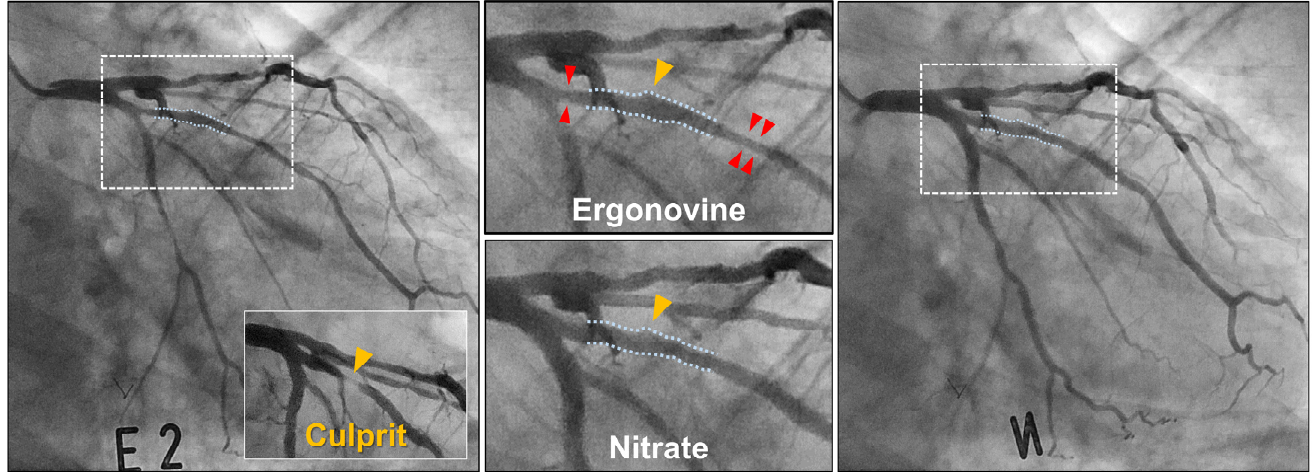
Figure 4. DCB-treated lesion showing constrictor resistance. The DCB-dilated culprit site (yellow arrowheads) is nearly unaffected by ergonovine, while the adjacent proximal and distal portions show vasoconstrictor response (red arrowheads).